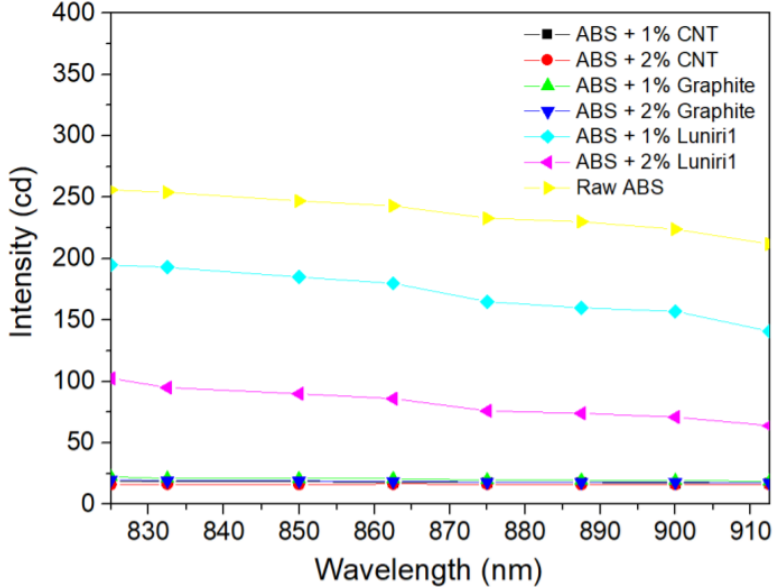
Figure 10. Light transmission of ABS filaments with different additives. Graphite and CNT achieved the best NIR absorption for both PLA and ABS. Graphite was selected for further filament extrusion as it is exponentially cheaper and results in a consistent filaments’ diameter than CNT whilst having similar NIR absorption properties. Hence, PLA and ABS with 2% graphite filaments would be used for FFF 3D printing of testing specimen.